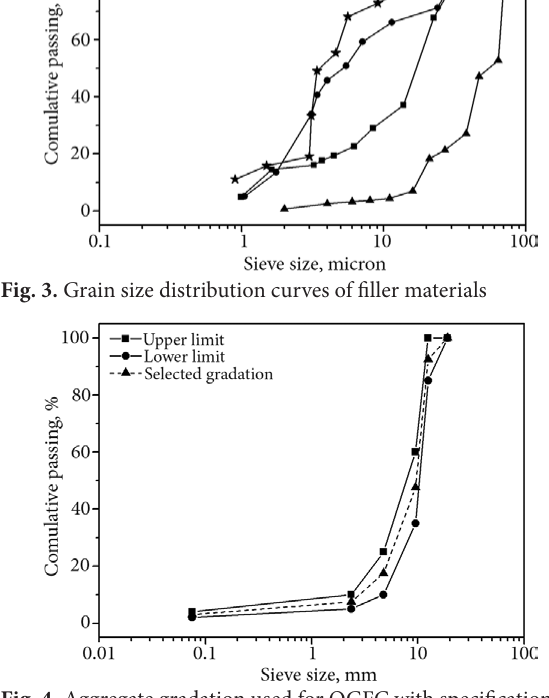
Fig. 4. Aggregate gradation used for OGFC with specification limits Table 4. Results for stone-on-stone criterion